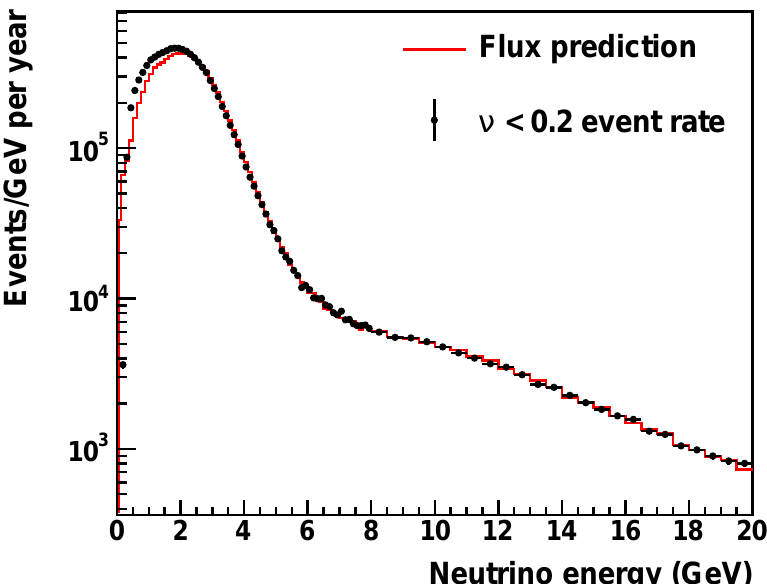
Figure 41. The FHC flux is compared to a sample of selected low- ν events from ND-LAr. The shape matches well above 4 GeV, with distortions up to 30% at 1 GeV. The details of the selection and reconstruction are described in the